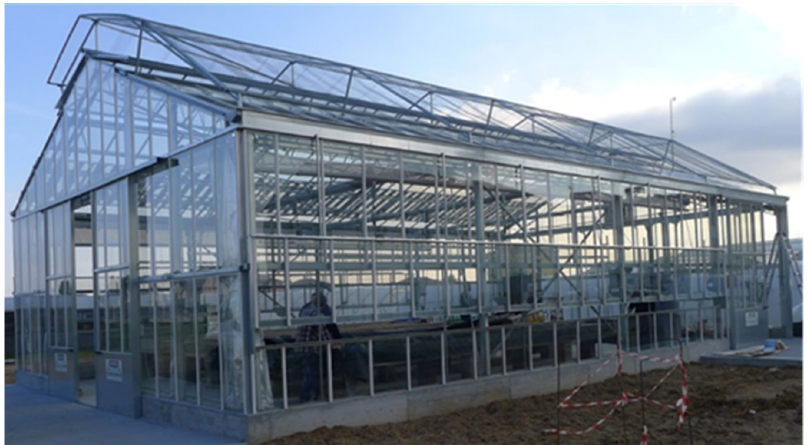
Figure 1. SamLab